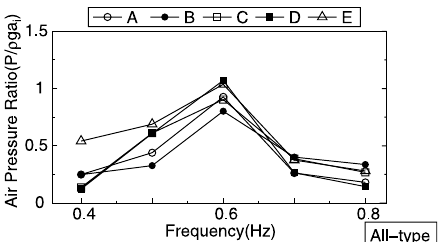
Fig. 9 Frequency Response of Air Pressure Ratio for five types BBDB